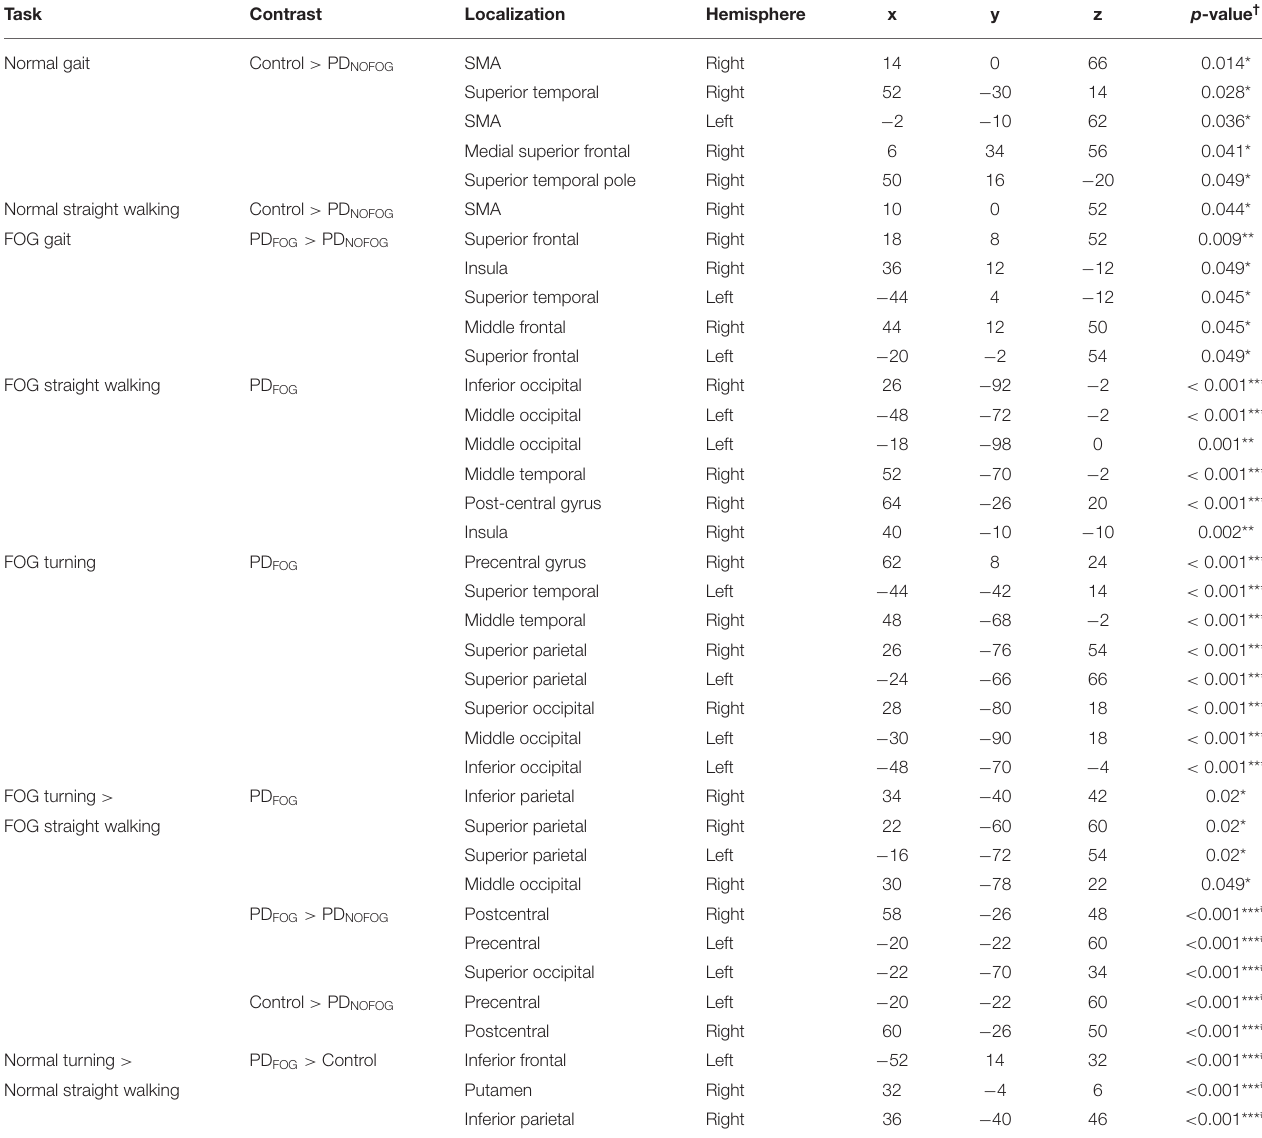
TABLE 2 | Results from the blocked design analysis.